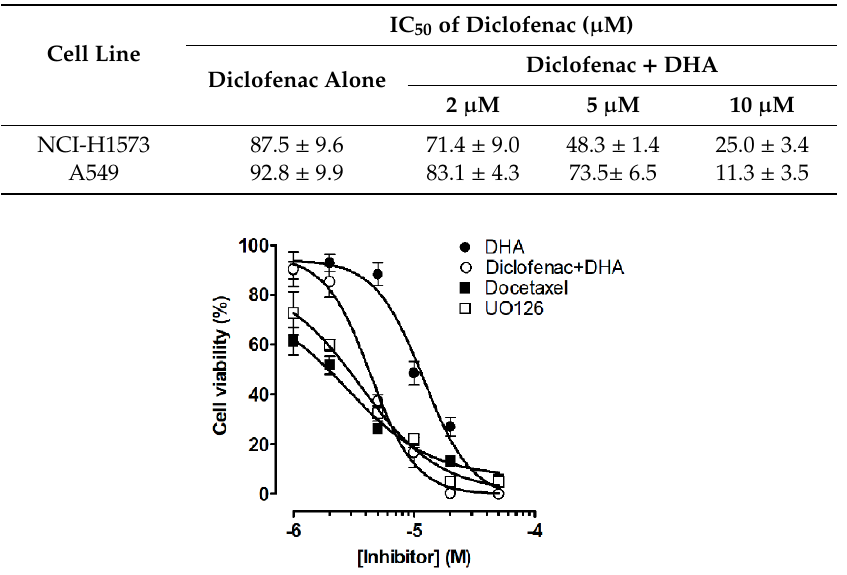
Figure 1. Suppression of cell viability by co-treatment of DHA and diclofenac in NCI-H1573 and A549 human lung cancer cells. Cultured cells were seeded in 96-well plates seeded at a density of 1 × 10 4 were exposed to diclofenac (0–500 μ M) alone or with DHA ( ● 0 μ M, ○ 2 μ M, ■ 5 μ M or □ 10 μ M) for 48 h. Cell viabilities were determined after the final treatment by fluorescence using the resazurin reduction assay. Each point represents the mean ± SEM relative to the control untreated cells. Table 2. IC 50 of diclofenac alone and co-treatment with DHA (2, 5 and 10 µ M) in NCI-H1573 and A549 human lung cancer cells.